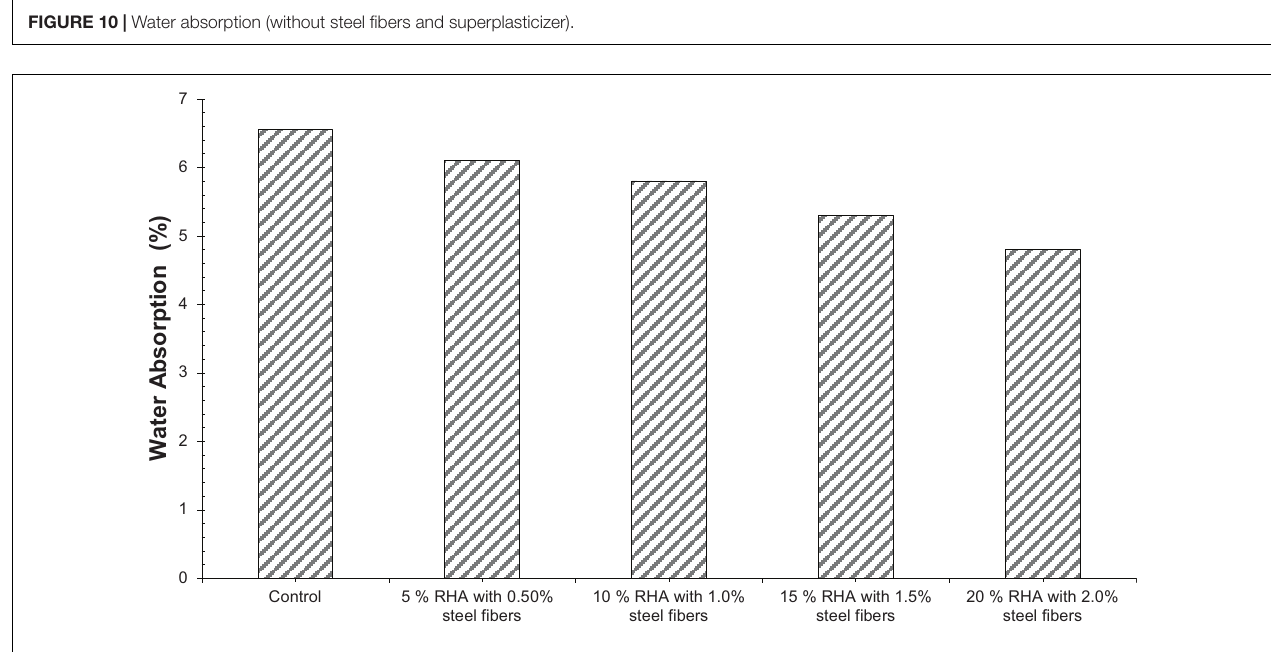
FIGURE 11 | Water absorption (with steel fibers and super